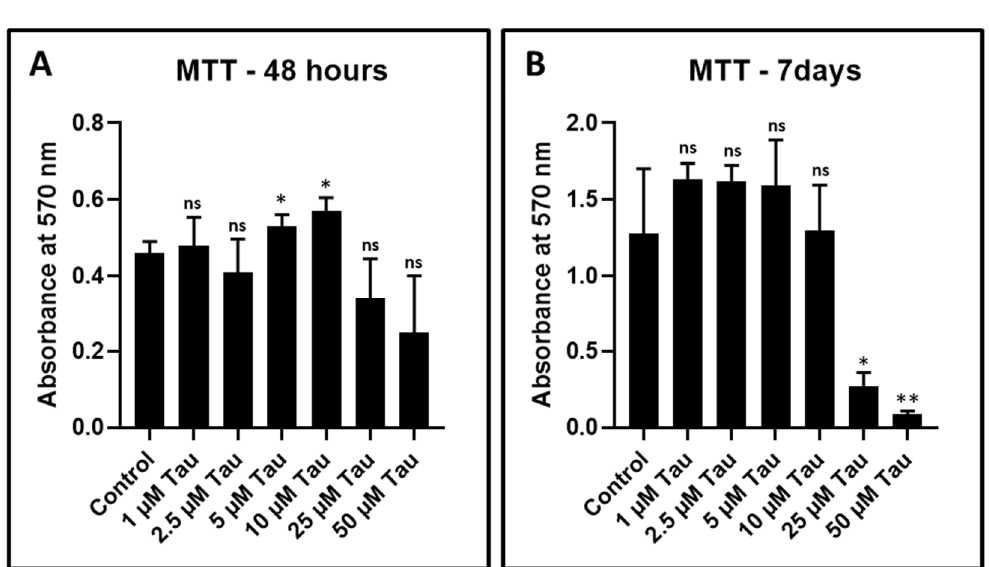
Figure 2. MTT assay to assess the cytotoxicity of taurine to DPSCs. ( A , B ) DPSCs were treated with various concentrations of taurine (1 µ M, 2.5 µ M, 5 µ M, 10 µ M, 25 µ M, and 50 µ M) for 48 h and seven days and comparative analysis was done to check the cytotoxicity of taurine to DPSCs. ns: not significant, * p < 0.05, ** p < 0.01. Tau: Taurine.